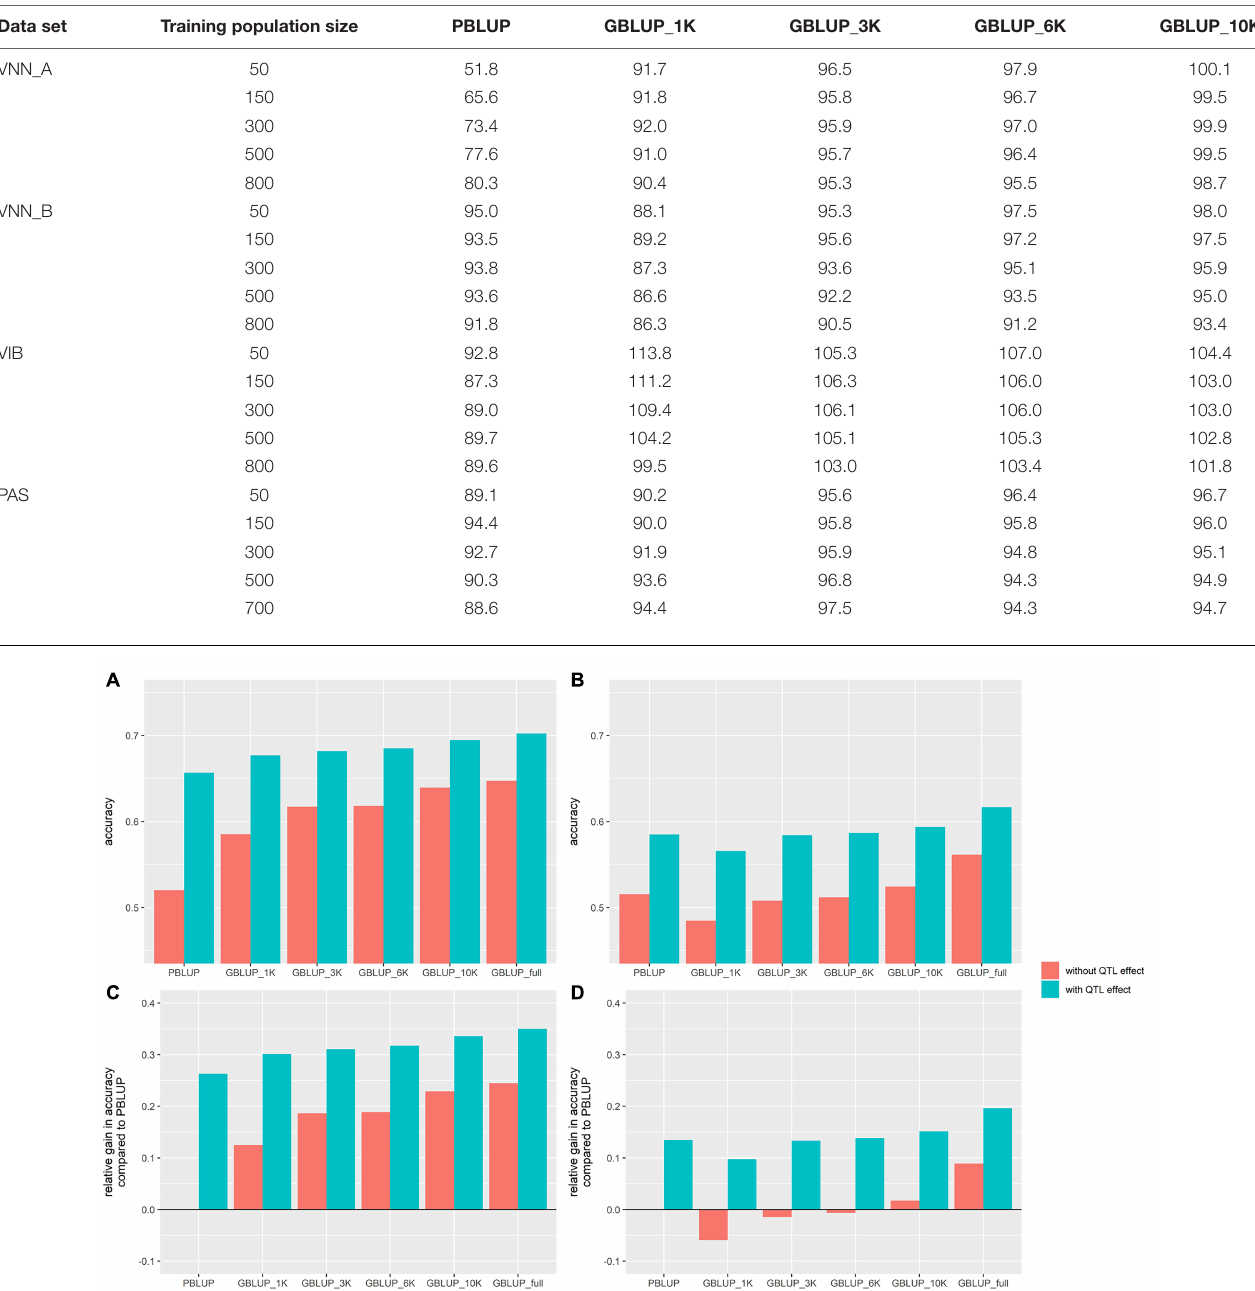
TABLE 4 | Relative prediction accuracy of estimated breeding values (EBV) (in %) compared to GBLUP_full for Viral Nervous Necrosis (VNN) resistance in two European sea bass commercial cohorts (VNN_A and VNN_B), vibriosis resistance in one European sea bass commercial cohort (VIB) and pasteurellosis resistance in one gilthead sea bream commercial cohort (PAS) using different training population sizes and marker densities.